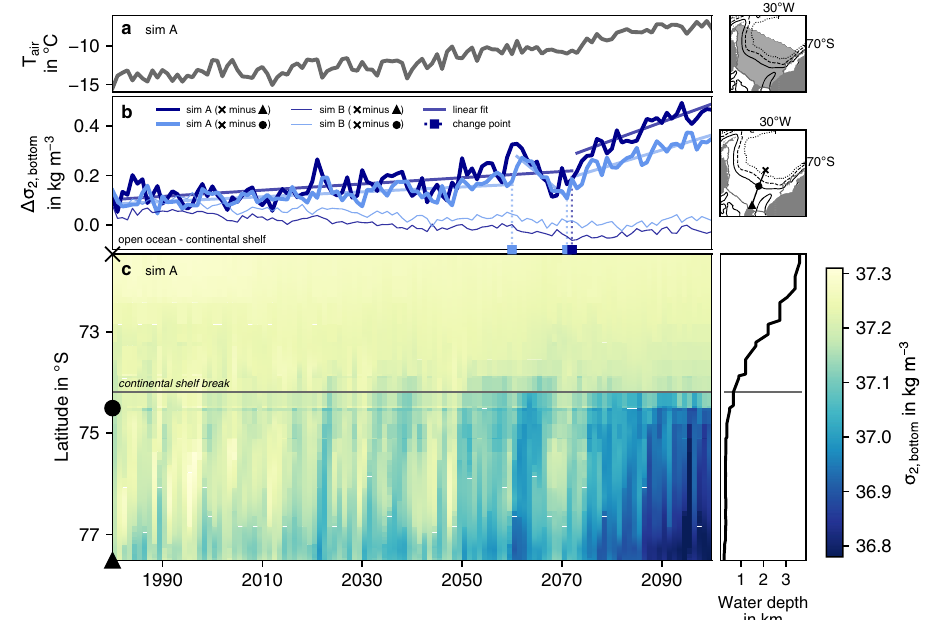
Fig. 5 Evolution of bottom density between 1980 and 2100 in the southern Weddell Sea. a Shows the average air temperature in ∘ C over the southern Weddell Sea (see map) used to force simA (historical + SSP5-8.5). b Shows the difference in bottom potential density anomalies ( σ 2 in kg m − 3 , i.e., potential density referenced to 2000 dbar minus 1000 kg m − 3 ) between the open ocean and two locations on the continental shelf (light and dark blue, respectively) in simA (thick lines) and in the control simulation simB (thin lines). See symbols in the map for the exact locations used to compute the density differences. For simA , the straight lines indicate the statistical models providing the best fi ts to describe the time series, and change points are indicated with vertical lines and as squares on the x axis (see Methods and refs. 62,63 ). c Indicates the corresponding evolution of bottom density along the whole transect in the southern Weddell Sea (see map) in simA (colors) and the bottom topography along this transect (black line). The location of the shelf break, de fi ned as the 700 m isobath, is denoted by the horizontal grey line.